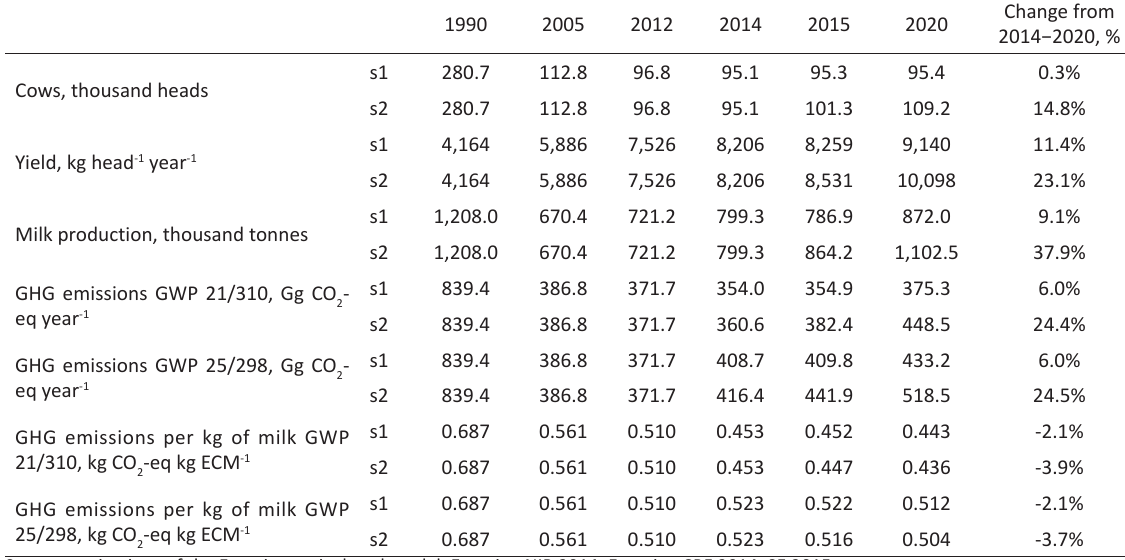
Table 2. The actual (1990, 2005, 2012, 2014) and projected (2015 − 2020) number of dairy cows, average milk yield, milk production and GHG